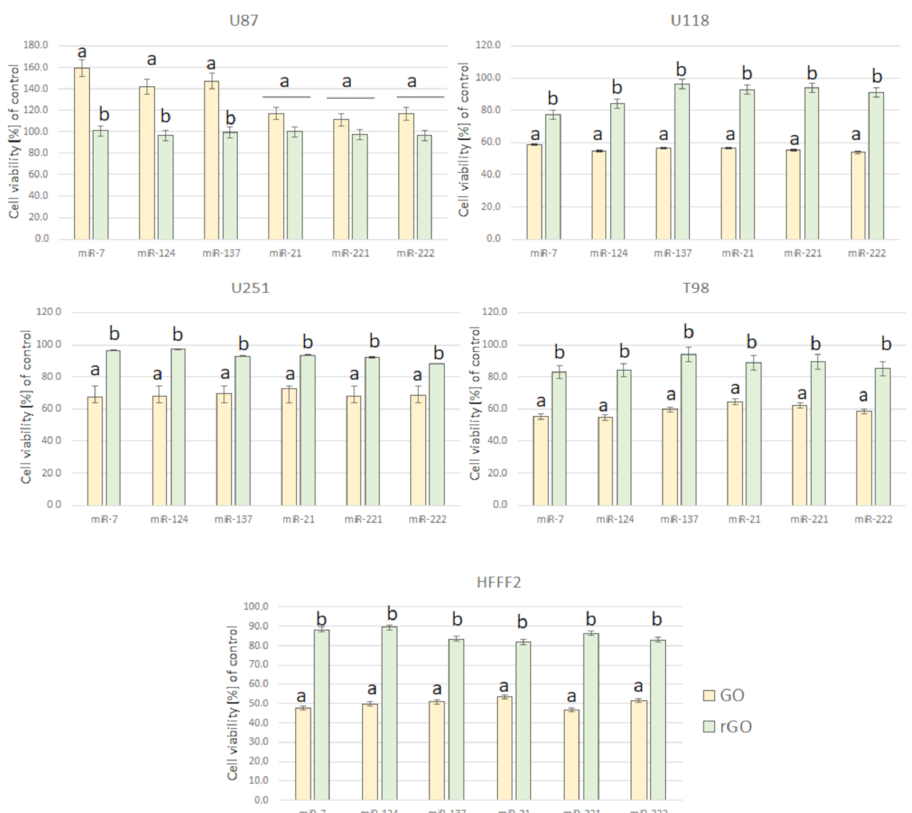
Figure 15. Effect of complexes of GO + miRNA and rGO + miRNA on U87, U118, U251 and T98 GBM cell lines and HFFF-2 human fibroblast viability. Notes: Different lowercase letters (a, b) within columns indicate significant differences between the miRNAs ( p < 0.05). Abbreviations: GO: graphene oxide, rGO: reduced graphene oxide.